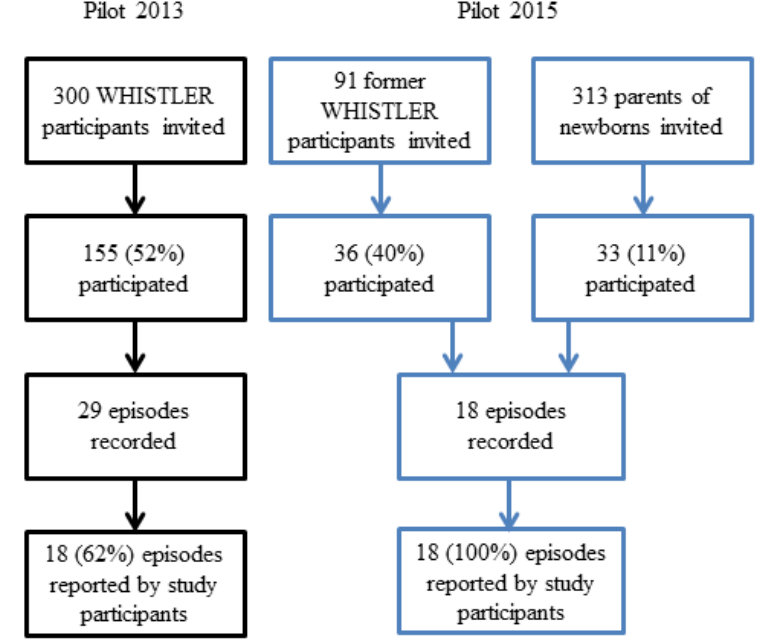
Figure 3. Flowcharts of the study population. WHISTLER: Wheezing and Illnesses Study Leidsche